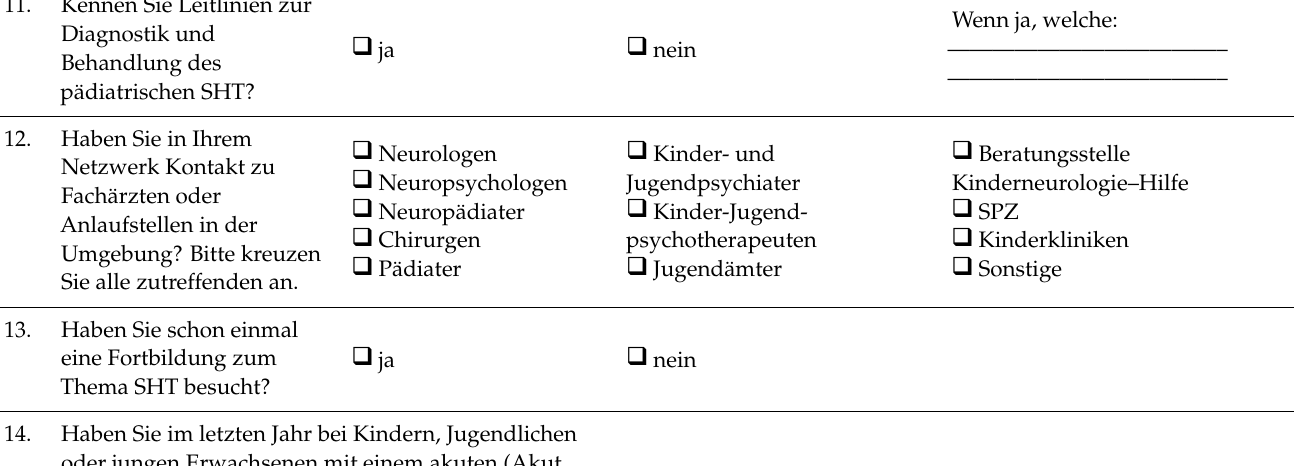
mitgegeben (z.B. Flyer) Behandlern weitergegeben